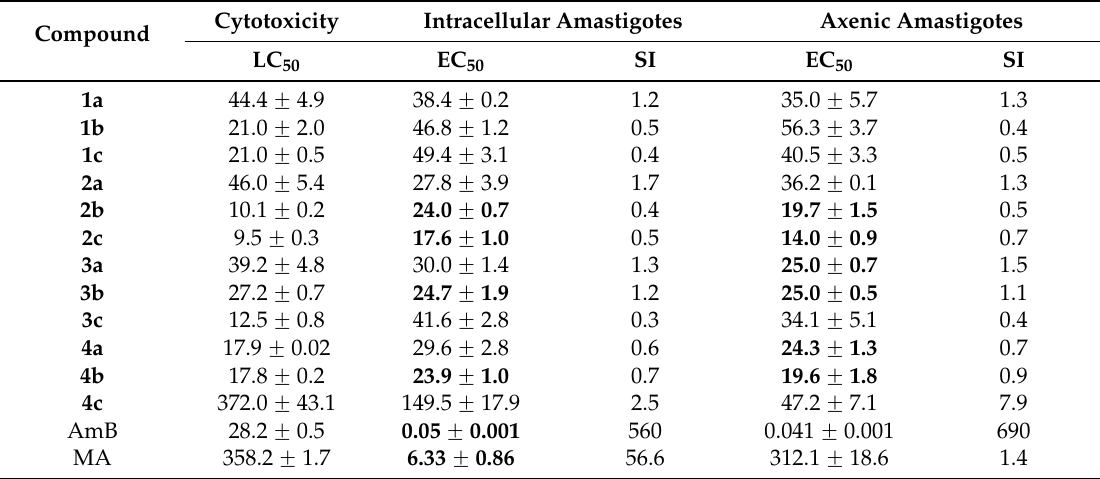
Table 1. Cytotoxicity against U-937 cells and antileishmanial activity of N -(halomethylated) ammonium salts, non N -(halomethylated) ammonium salts and choline and halogenated cholines. Cytotoxicity Intracellular Amastigotes Axenic Amastigotes Compound LC 50 EC